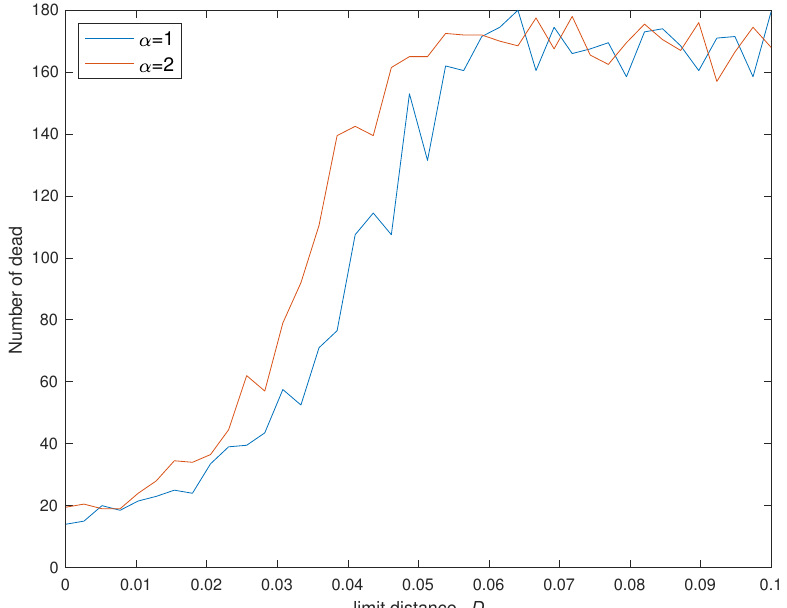
Figure 8. Variation of the number of dead ( I 3 ) versus the social neighborhood D for α = { 1,2 } ( N = 500, n i = 50, δ = 0.1, p 1 = 0.1, p 2 = 0.9, p 3 = 0.7, p 4 = 0.05, p 5 = 0.02 and N h → ∞ ).